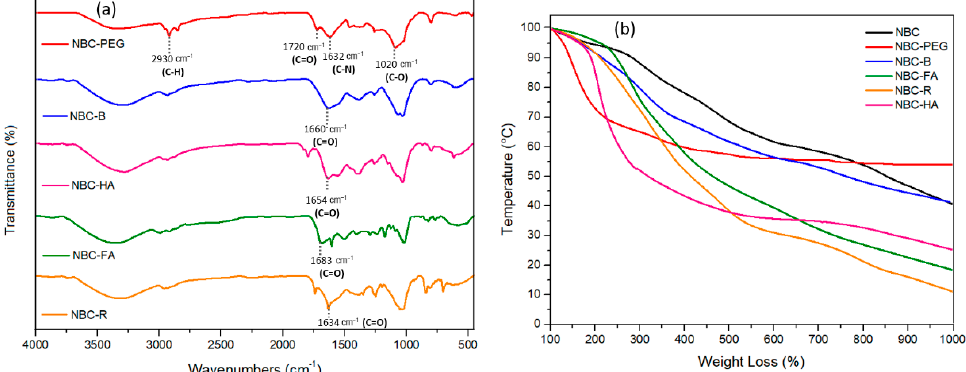
Figure 6. FTIR spectra ( a ) and TGA profiles ( b ) of NBC-PEG and of the TL-conjugated samples NBC- B, NBC-HA, NBC-FA and